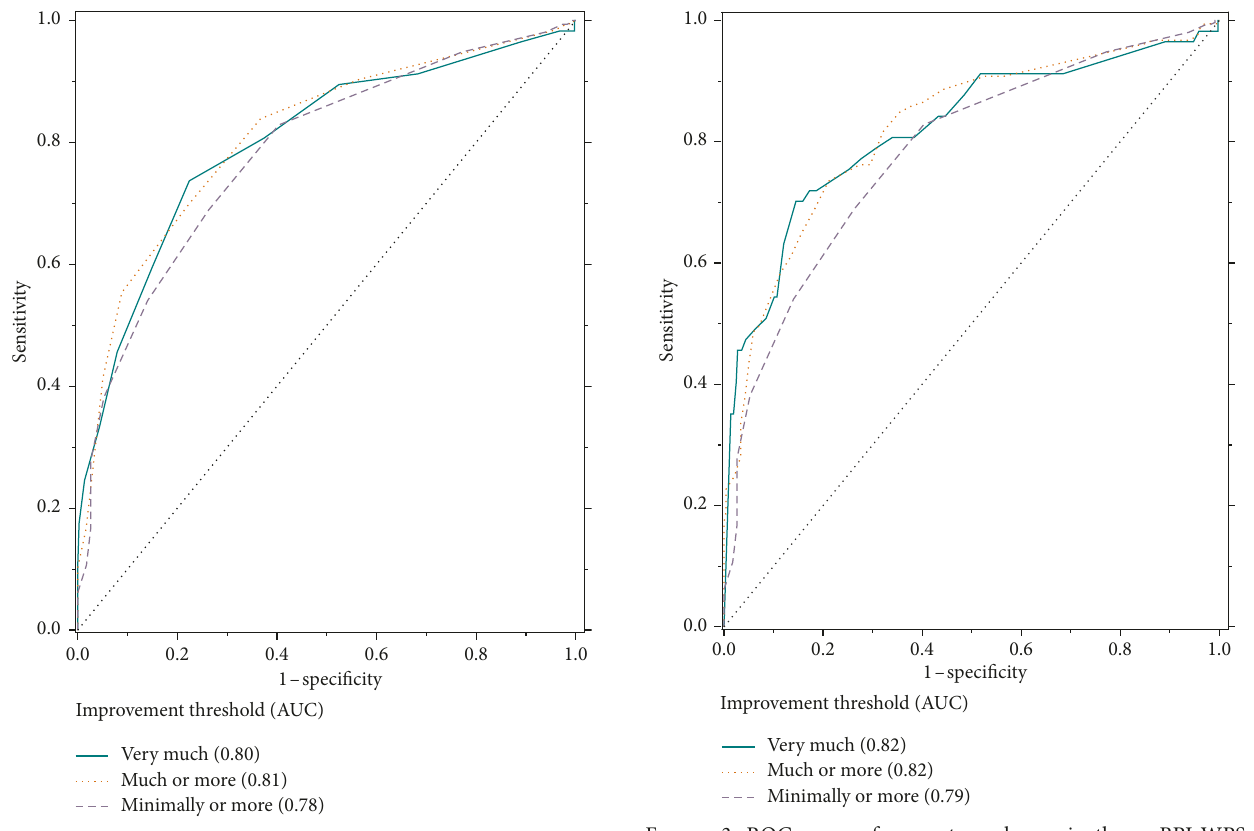
Figure 2: ROC curve of raw change in the m-BPI-WPS score from the baseline to week 5/end of the study and PGIC. AUC, area under the curve; m-BPI-WPS, modified Brief Pain Inventory-worst pain severity; ROC, receiver operating characteristic.